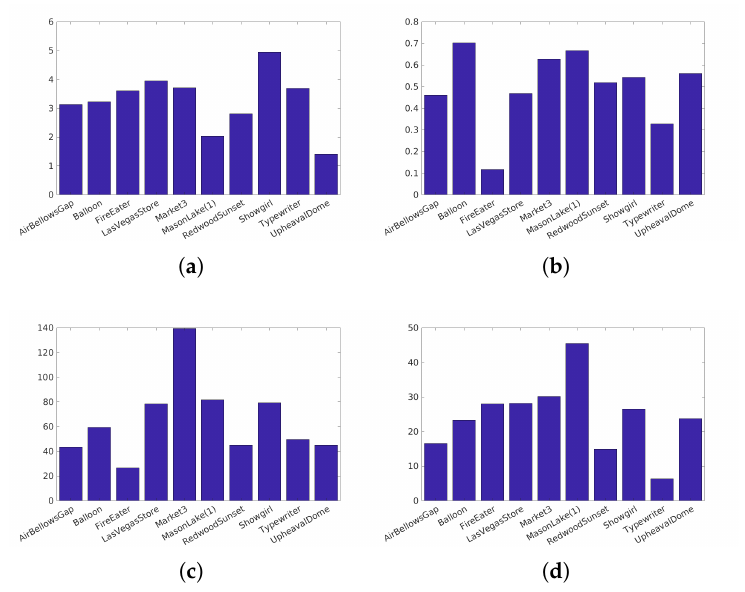
Figure 5. Characteristics of the Zerman et al. [19] images: ( a ) The dynamic range, ( b ) key, ( c ) spatial Information, ( d )